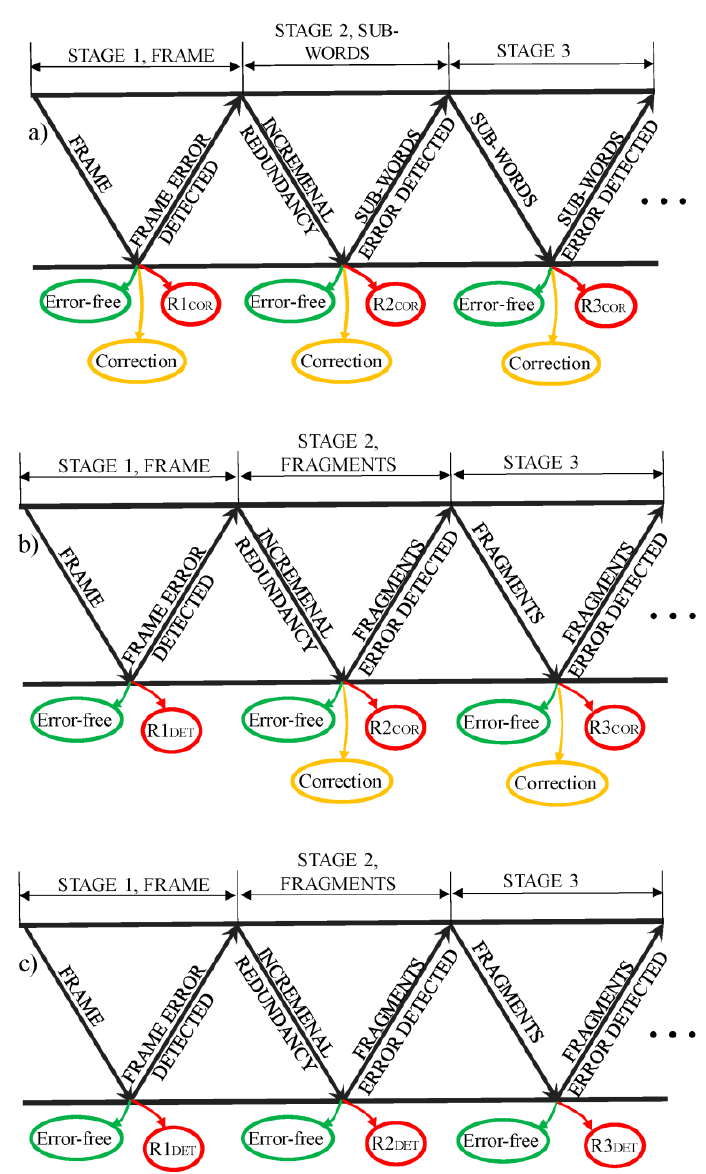
Figure 6. Different scenarios of the proposed hybrid incremental ARQ based on splitting code: ( a ) error correction performed at frame and at fragment stages; ( b ) error correction performed at fragment stages only; ( c ) no error correction performed. Frame, its incremental redundancy and its erroneous fragments are sent in stages 1, 2 and 3, respectively. The frames/fragments that are error-free, corrected or with residual errors require no further